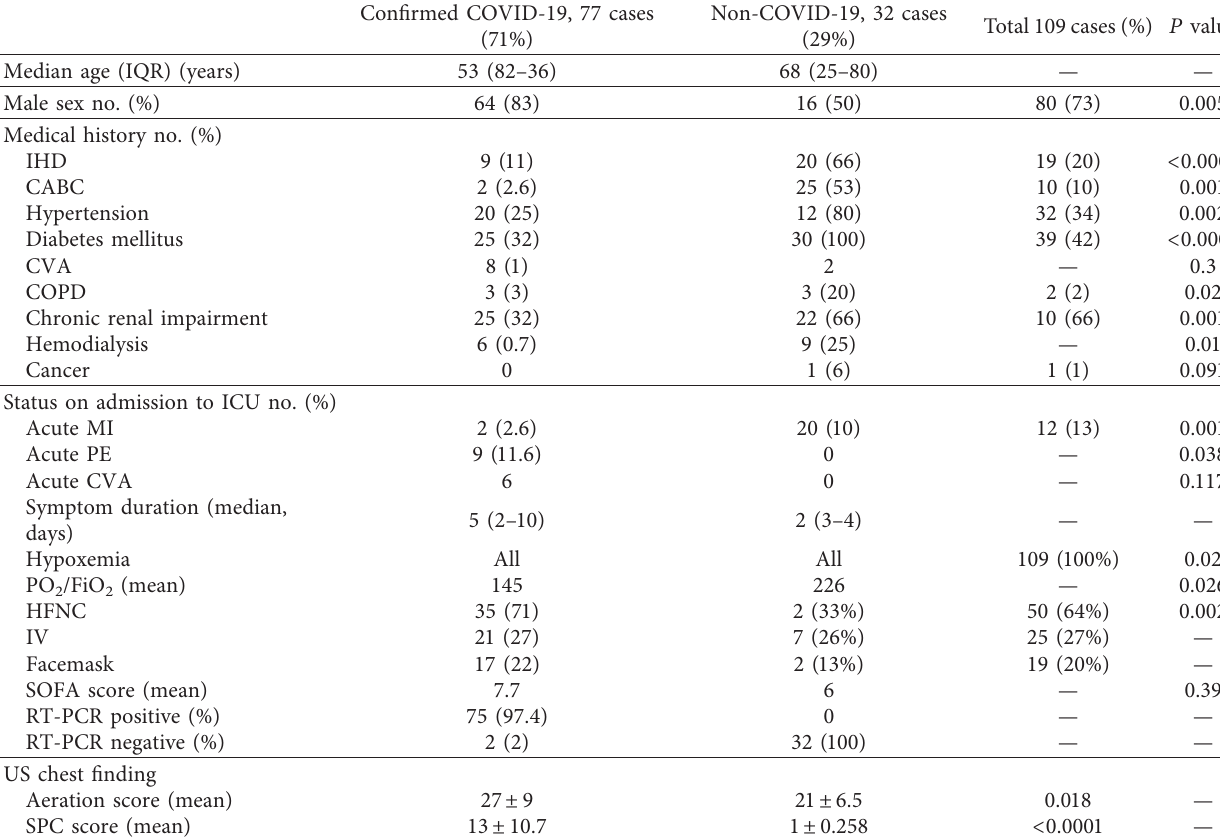
Table 1: Clinical characteristics of the patients.